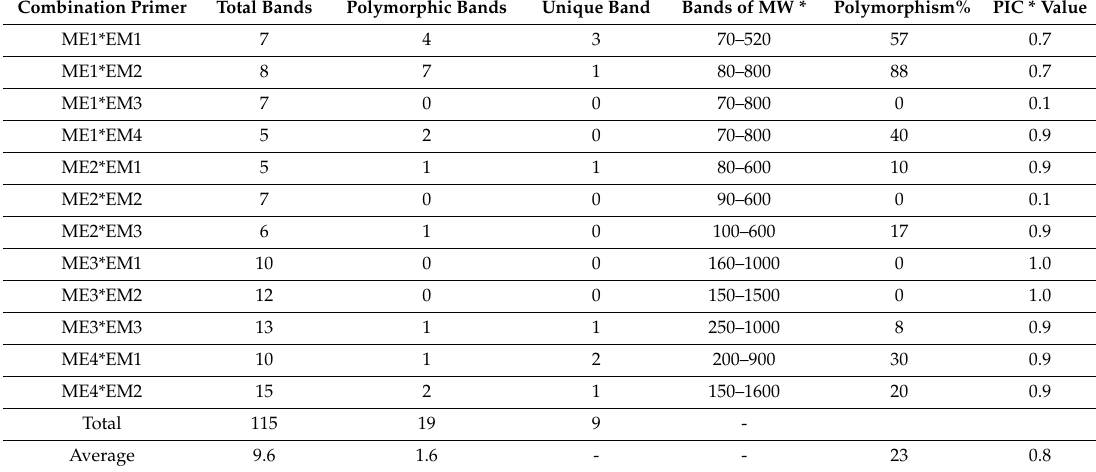
Table 7. Summary of SRAP data following analysis of control, BRs10 − 8 M and CHT 200 mg / L treatments.